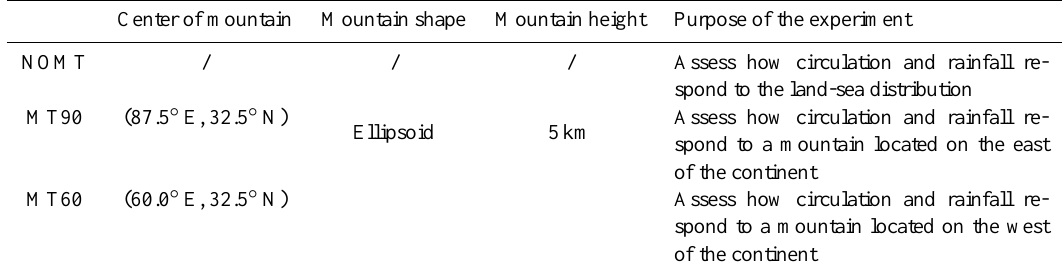
Table 1. Design of the aqua-planet sensitivity experiments using an idealized Afro-Eurasian continent. Center of mountain Mountain shape Mountain height Purpose of the experiment